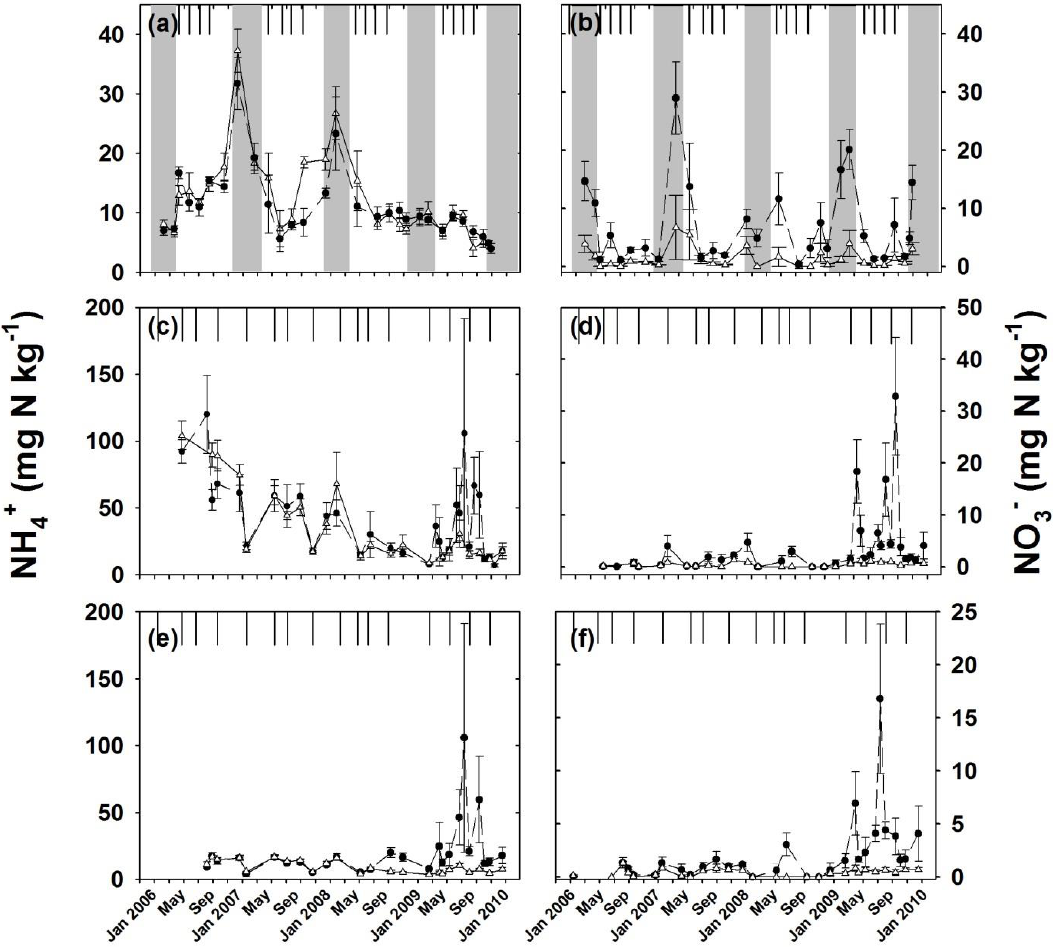
Fig. 2. Mean ( ± SE, n = 4) soil-extractable ammonium (NH + , left panels) and nitrate (NO − , right panels) at 0–0.05m mineral soil in the 4 3 control ( 4 ) and N-addition ( • ) plots of the lowland forest ( a and b ) and montane forest ( c and d for organic layer, e and f for 0–0.05m mineral soil). The black vertical lines indicate dates of N addition during 9–12yr of treatment in the lowland forest and 1–4yr of treatment in the montane forest. Grey shadings in (a) and (b) mark the dry seasons. The first two years were previously reported by Koehler et al.